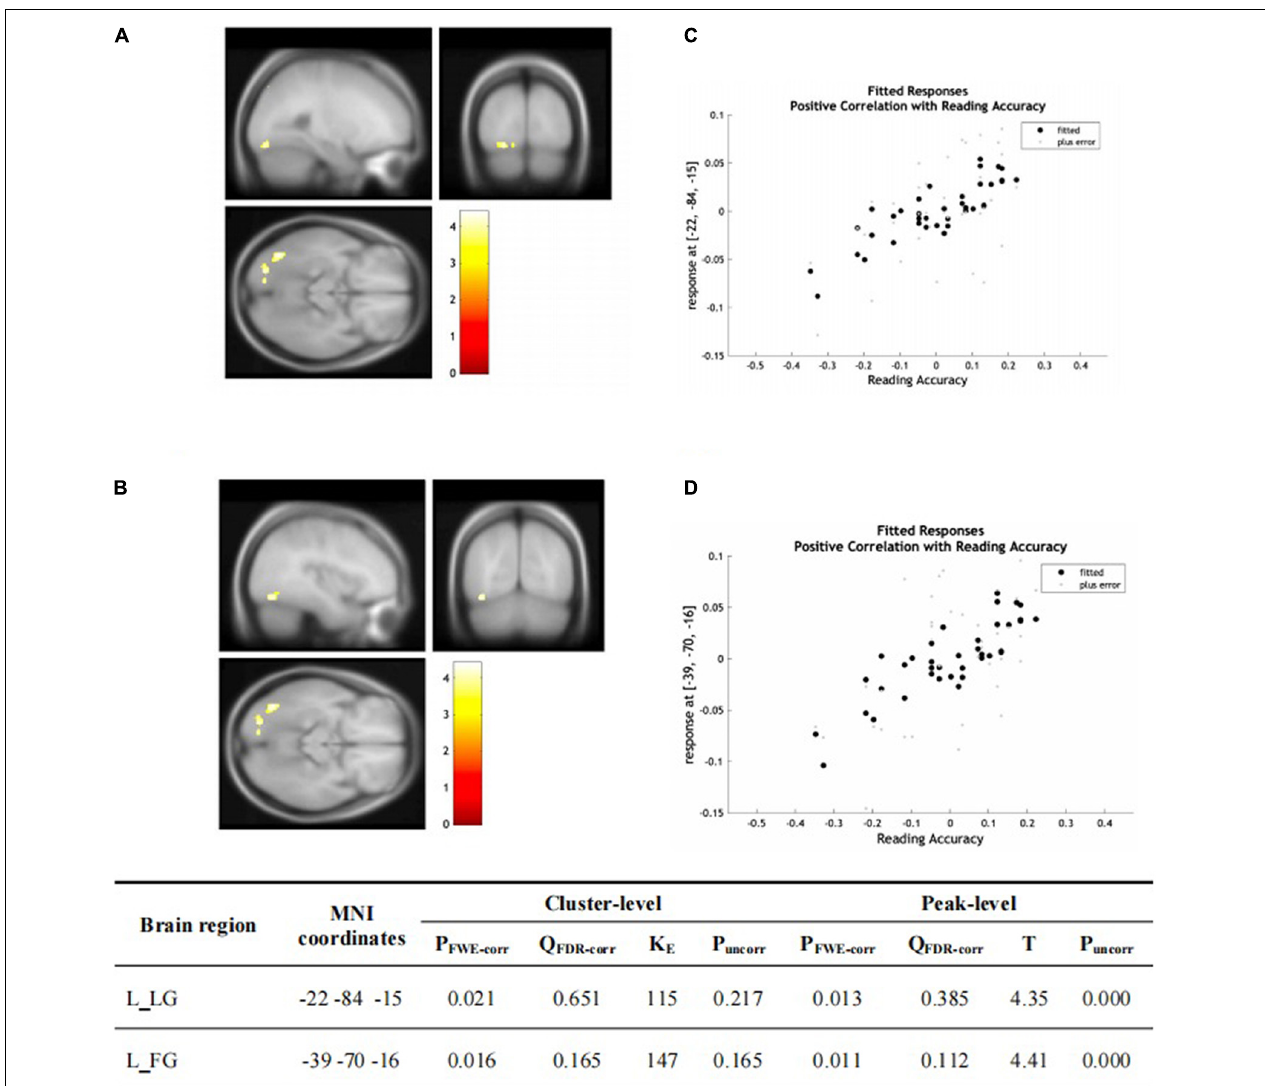
FIGURE 3 | (A,B) Statistical parametric maps (threshold at P < 0.001, uncorrected for display purpose showing the results from the regression analysis of Chinese characters’ reading accuracy on grey matter volume using VBM). Sex, ages, AoA-L2, the number of languages learned, Raven’s performance were considered as the covariates and then were regressed out in the statistical analysis. Increased GMV in left LG [showed in (A) ] and left FG [showed in (B) ] was associated with higher accuracy of Chinese characters recognition for all the subjects, respectively. This result was significant after correction for multiple comparisons using small volume corrections ( P < 0.05). (C) GMV in the cluster centered at (–22, –84, –15) correlates with reading accuracy of Chinese characters across the two groups in the left LG. (D) GMV in the cluster centered at (–39, –70, –16) correlates with reading accuracy of Chinese characters across the two groups in the left